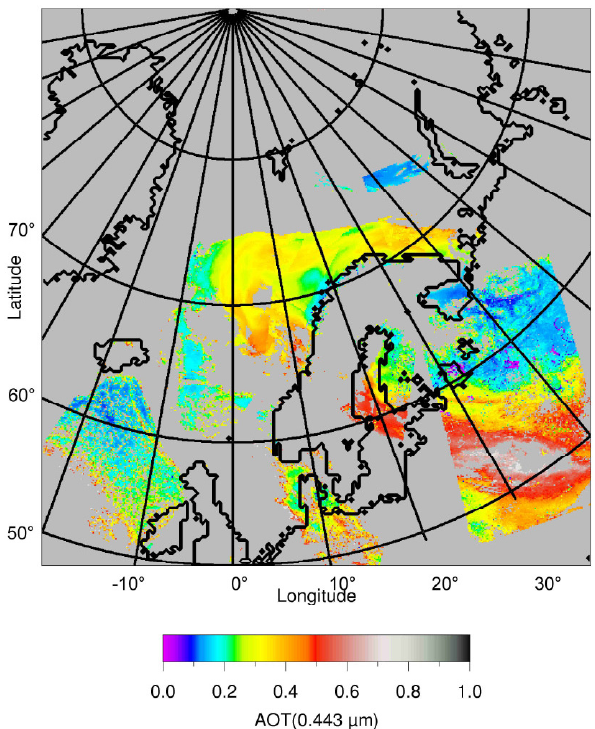
Fig. 13. Composite of MERIS AOT retrievals at the wavelength 0.443µm for 3 orbits of MERIS RR data over northern Europe for 1 May 2006, showing pollution transport around a high pressure system over northern Russia. The scene shows a large scale pollu- tion transport from Europe to the Arctic, causing arctic haze. The atmospheric conditions and the study of pollution transport is dis- cussed in detail by Treffeisen et al. (2007). The highest values of AOT in the pollution plume over Russia are screened out by the cloud screening, also scattered clouds are not removed totally, be- cause not all criteria of the cloud screening have been applied.